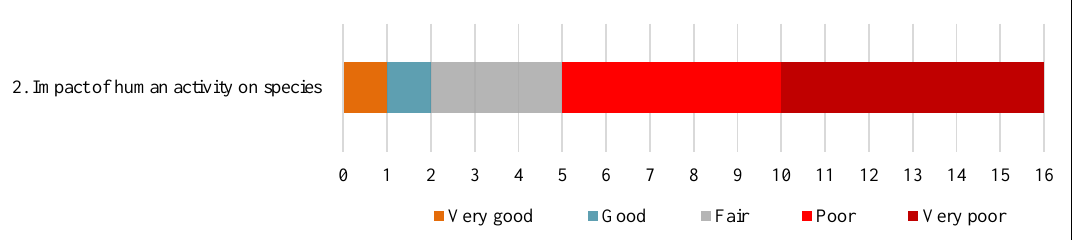
Figure 3. Environmental dimension